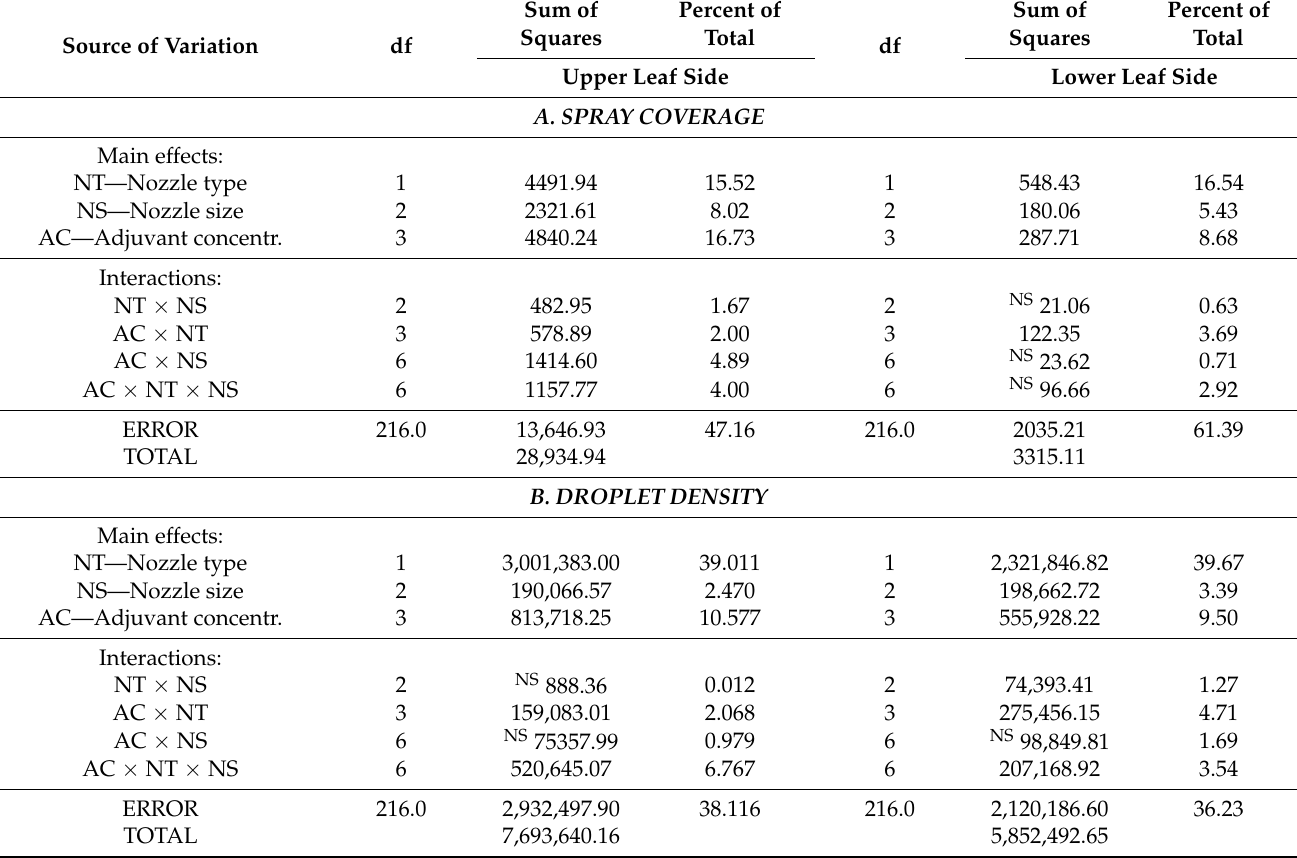
Table 6. The ANOVA summary table for data sets of spray coverage (A) and droplet density (B) on upper and lower surfaces of apple leaves obtained during the treatments with adjuvant Silwet L-77 + Delan 700 WG. The denotation NS marks not significant effects or interactions at p <